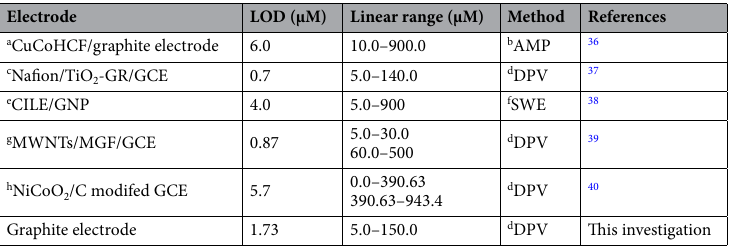
Table 2. Comparison of the results of previous electrochemical studies for the determination of L-tryptophan. a Copper-cobalt hexacyanoferrate film modified graphite electrode; b Amperometry; c Glassy carbon electrode modified with a Nafion/TiO 2 -graphene composite film; d Differential pulse voltammetry; e Carbon ionic liquid electrode (CILE) modified with gold nanoparticle (GNP); f Square wave voltammetry; g A multi-walled carbon nanotubes (MWNTs) bridged mesocellular graphene foam (MGF) nanocomposite(MWNTs/MGF) modified glassy carbon electrode; h Carbon-supported NiCoO 2 nanoparticles (NiCoO 2 /C) modified glassy carbon electrode (GCE).